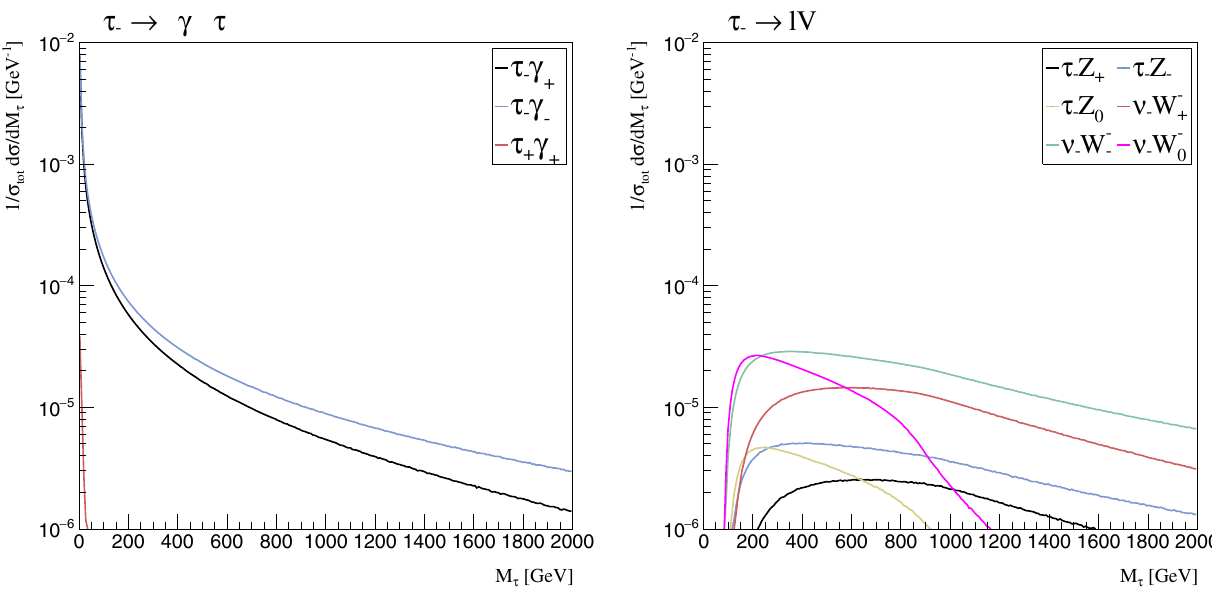
Fig. 1 Branching spectra of a 1 TeV τ − to τγ (left) and τ Z and ν τ W −